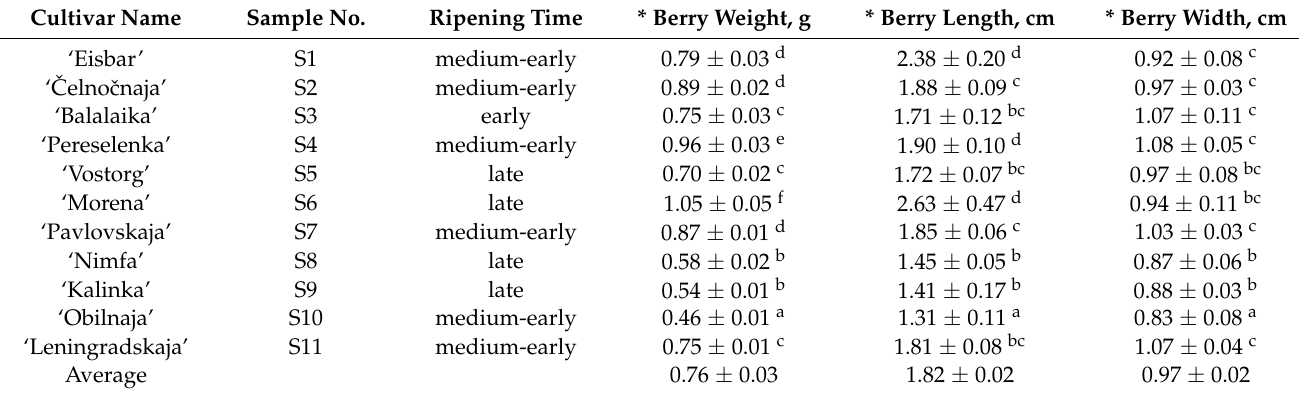
Table 1. Ripening time, berry weight and size characteristics (means ± SD) of Lonicera caerulea cultivars. Cultivar Name Sample No.